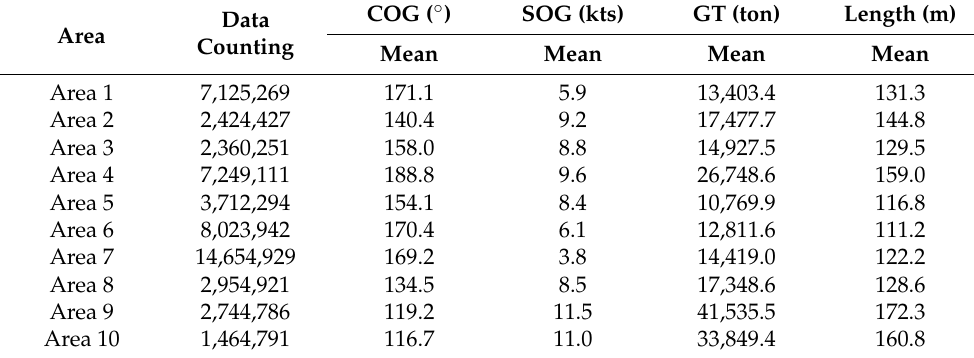
Table 3. AIS data statistics by